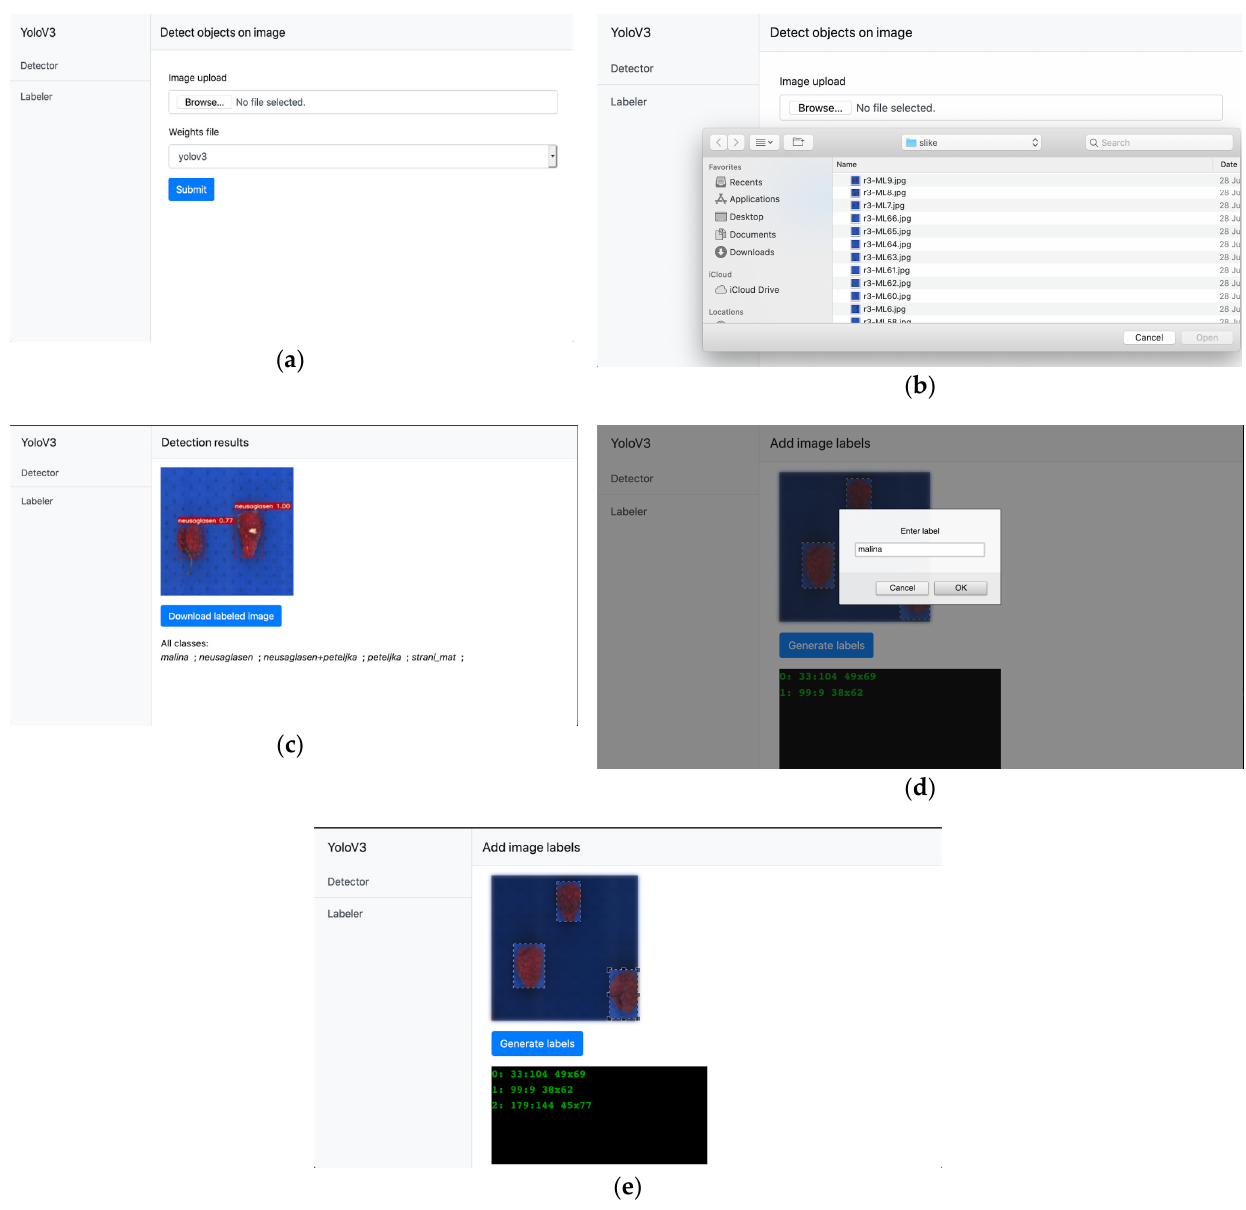
Figure 11. ( a ) Front page of the application for the selection of weight coefficients and images, ( b ) inserting an image, ( c ) detection results, ( d ) creating a new class, ( e ) labeling objects of interest.